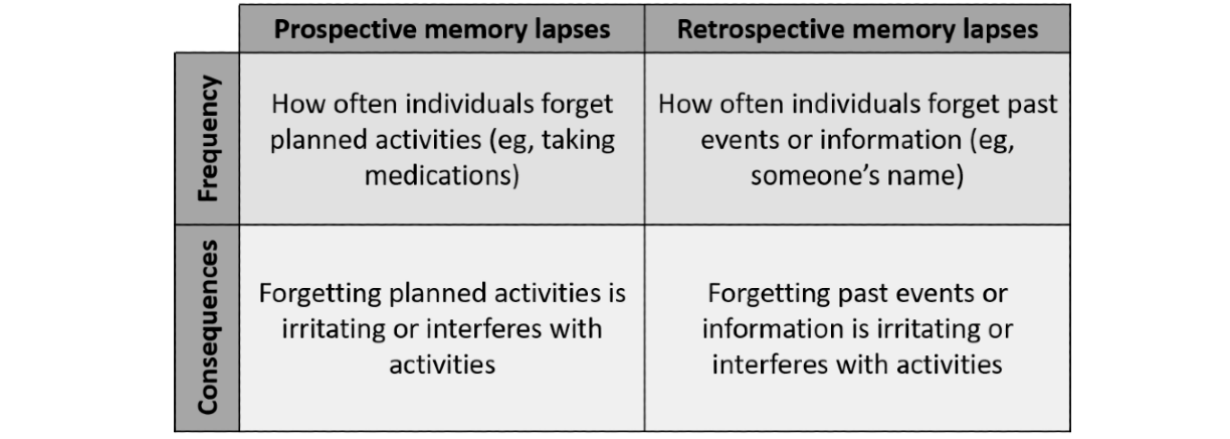
Figure 1. Features of memory lapses by the type of memory